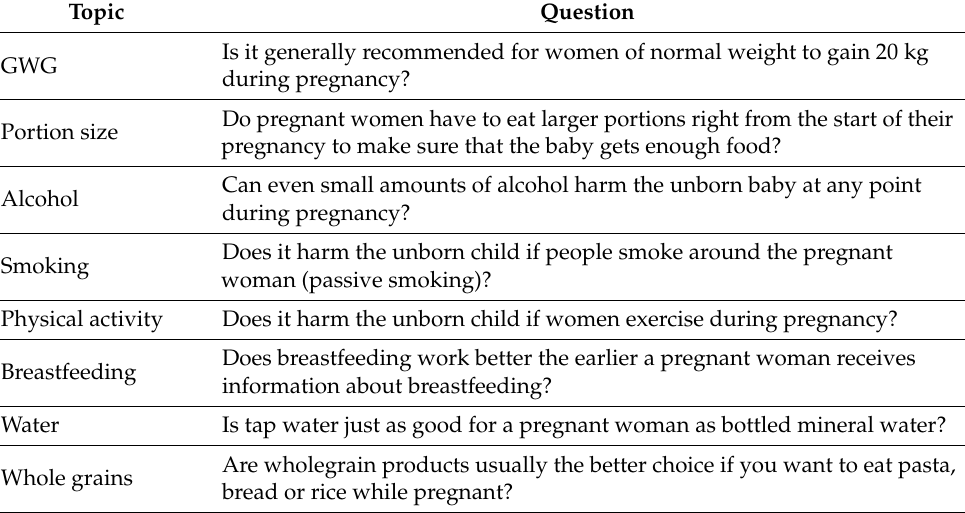
Table 1. Knowledge